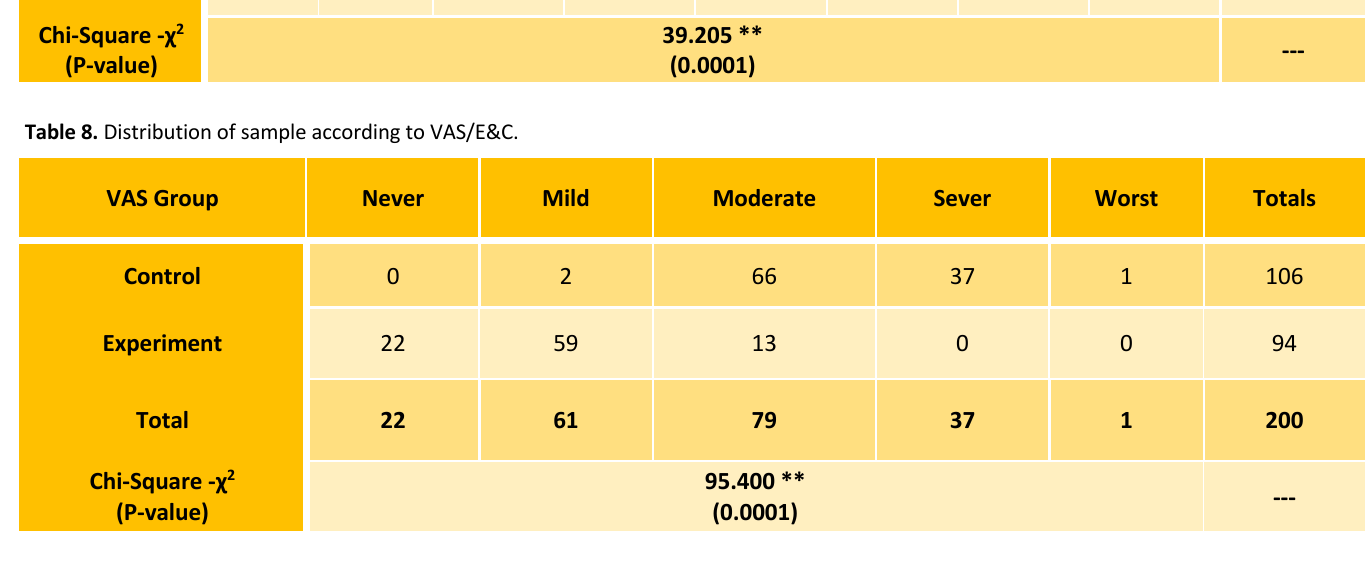
Table 9. Distribution of sample according to injection